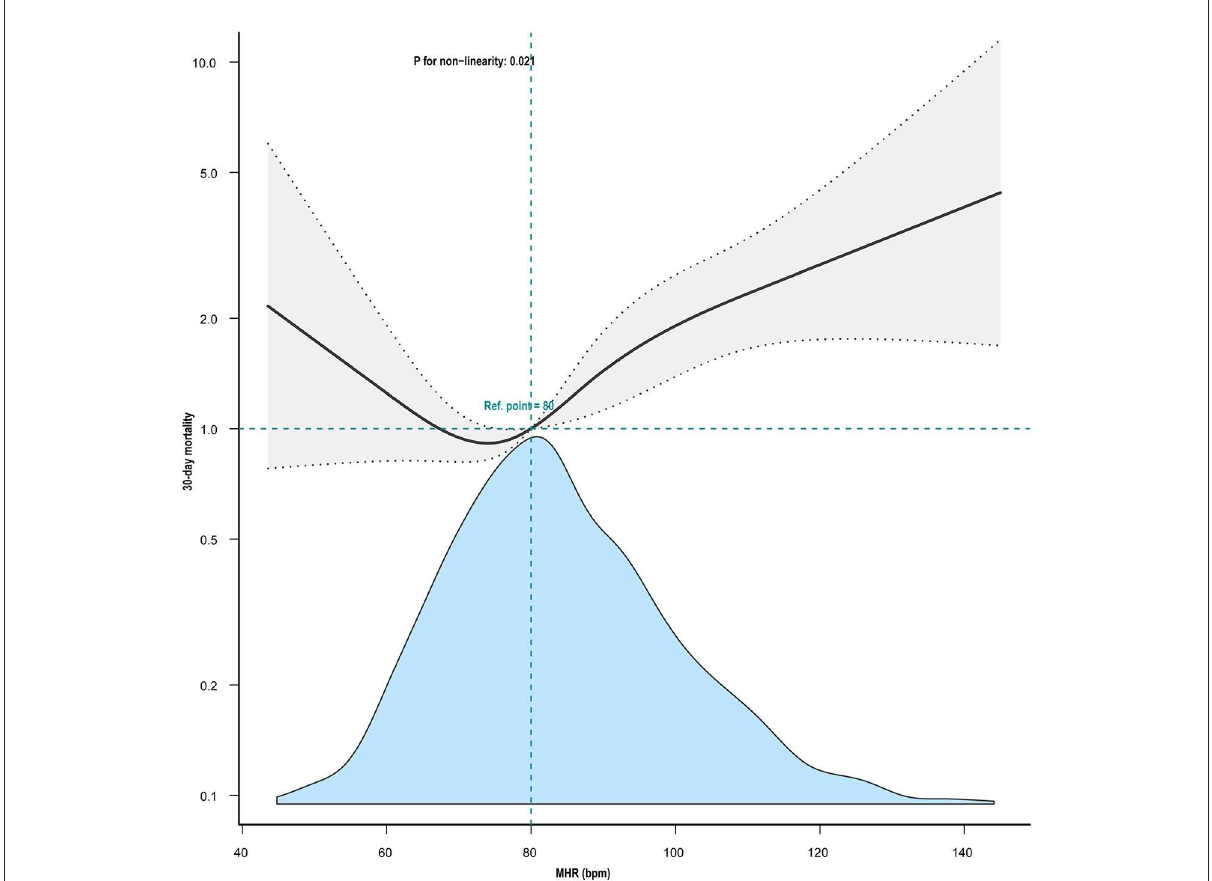
FIGURE2 Nonlinear association between mean heart rate and 30-day mortality. Adjustment factors included gender, mean SpO2, mean glucose, weight, SOFA score, Charlson’s comorbidity index, SAPS II, age, GCS, Ventilation use, and vasoactive drug use. The black line and gray area represent the estimated values and their corresponding 95% confidence intervals, respectively. MHR, mean heart rate; bpm, beats per minute.